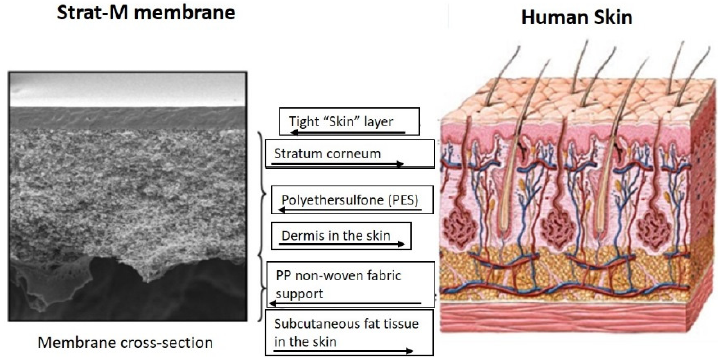
Figure 4. Comparison of Strat-M ™ membrane and the human skin. Reproduced with permission from Haq et al. [102].